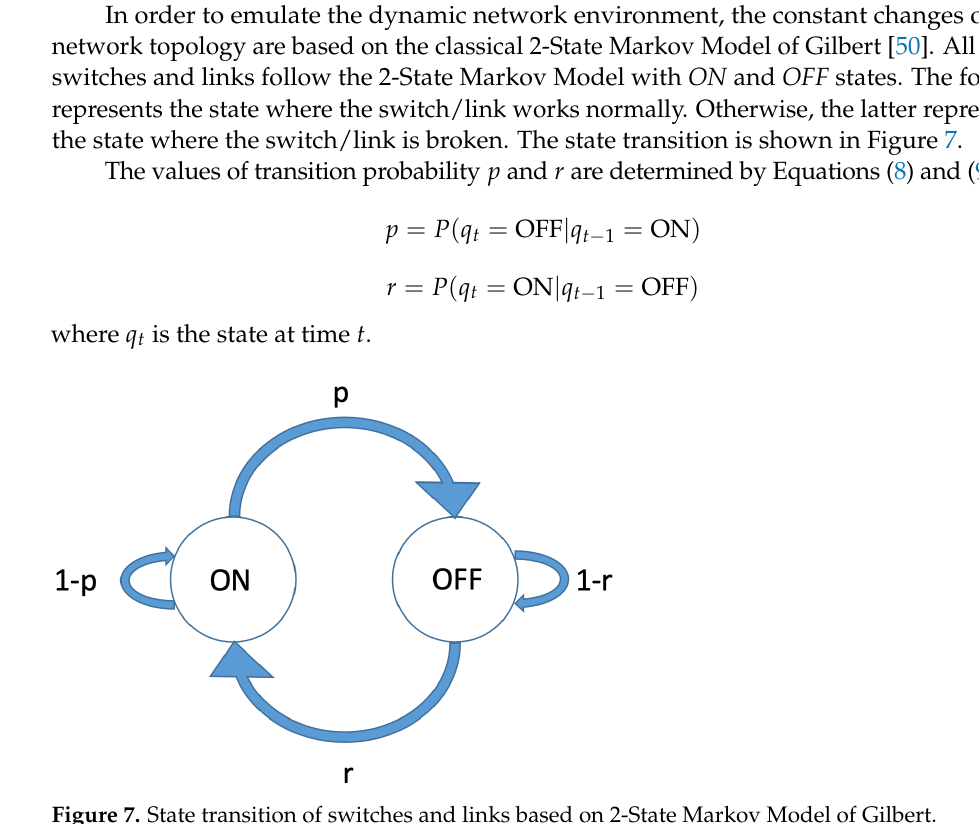
Figure 7. State transition of switches and links based on 2-State Markov Model of Gilbert. Based on the experiments, both values p and r are fixed to